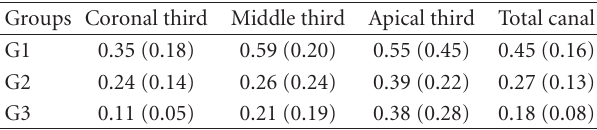
Figure 1: Outline of the total canal area and the filling debris area using AutoCAD 2004 software tool. Table 1: Mean (SD) filling debris area/canal area ratio obtained in the coronal, middle and apical third and also in the total